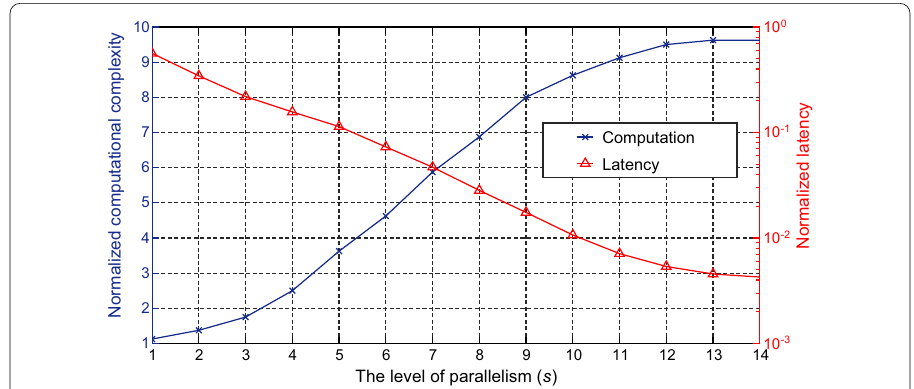
32,768 when the proposed decoding =